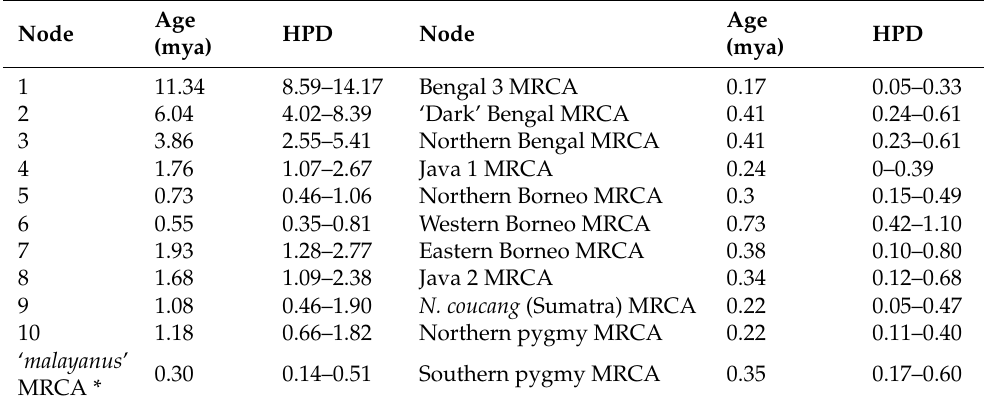
Table 3. Estimated divergence ages with 95% highest probability densities (HPDs) of nodes as presented in the phylogeny (in mya, million years ago). Node numbers are defined in Figure